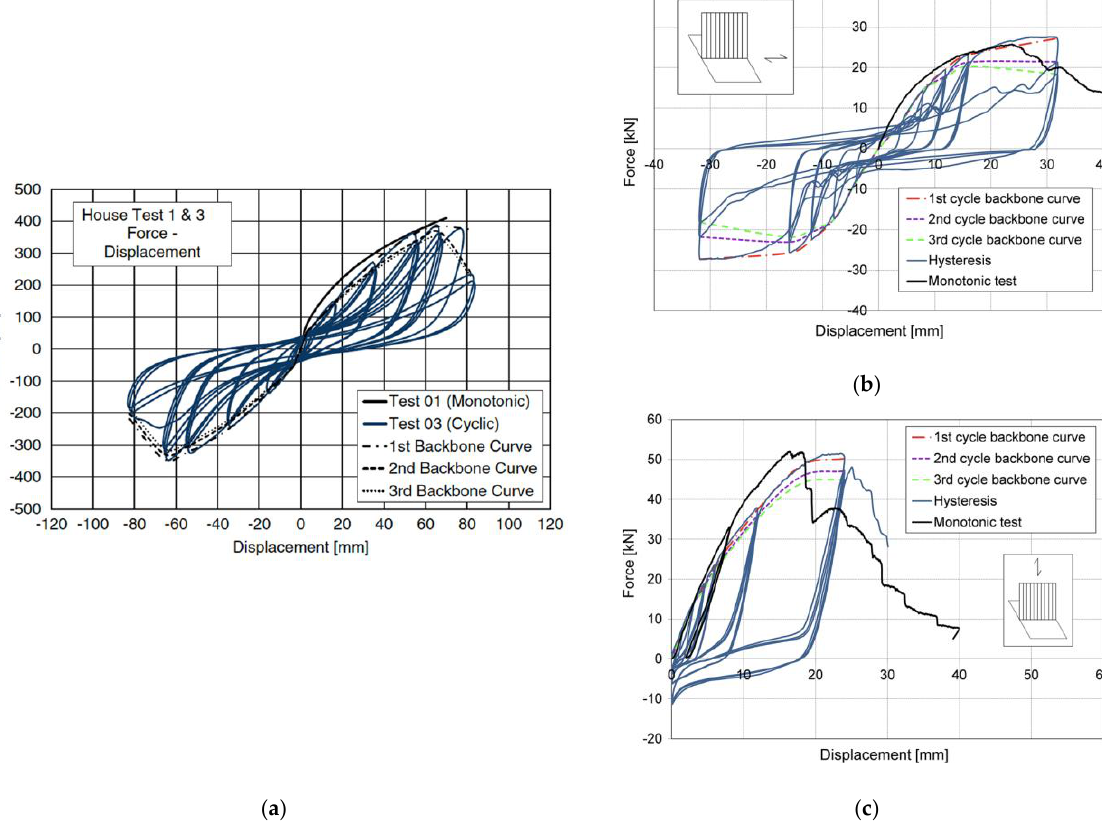
Figure 5. Hysteresis loops and monotonic curve for ( a ) a two-storey full-scale CLT building [19], and the ( b ) angle brackets and ( c ) hold-downs that are used in the building [24].